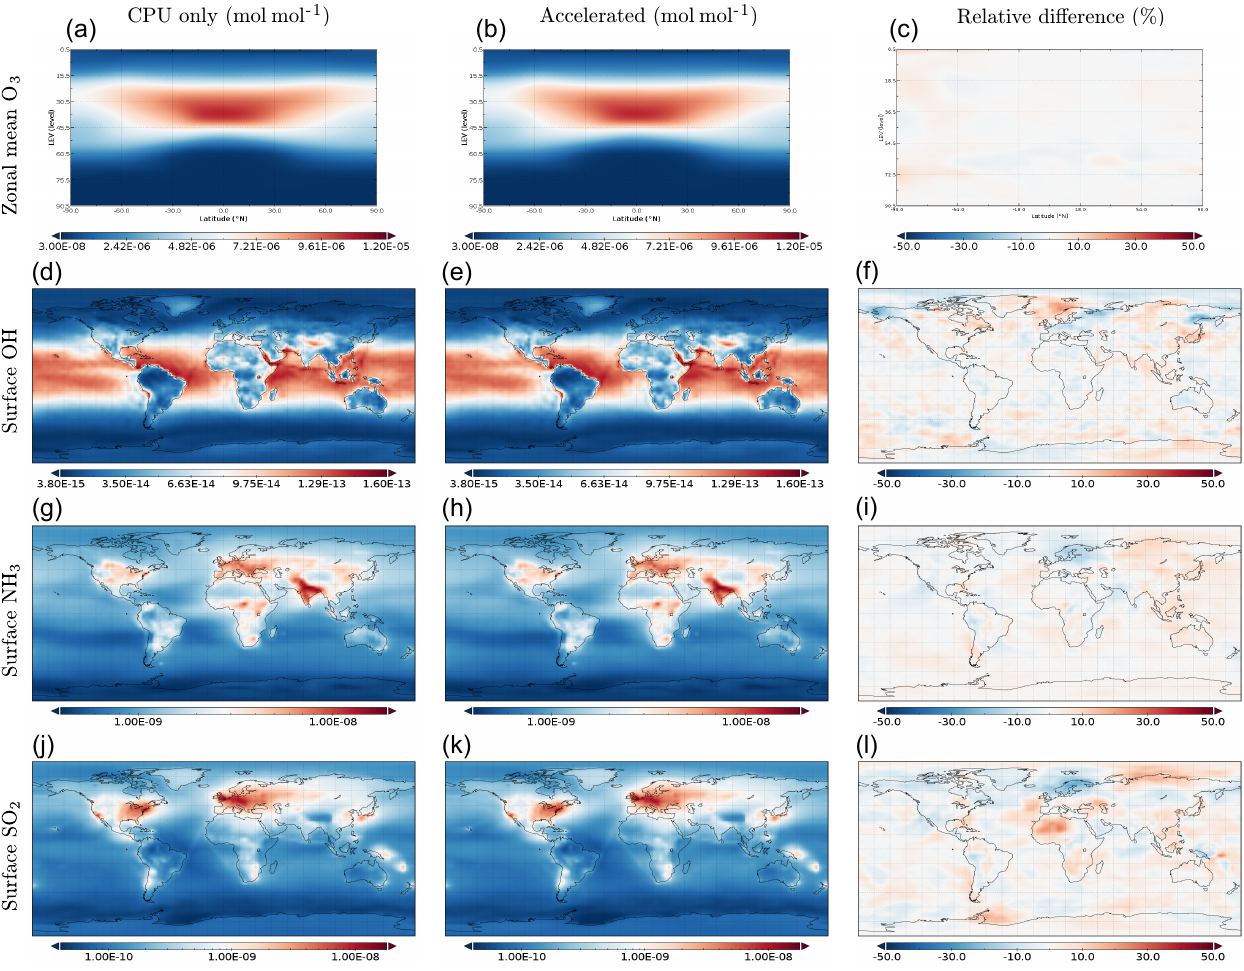
Figure 5. Output of CPU-only (a, d, j, g) , GPU-accelerated (b, e, h, k) 2-year simulations, and their relative difference (c, f, i, l) for different chemical species: O 3 zonal mean (a–c) and surface level OH , NH 3 , and SO 2 concentrations ( d–f , g–i , and j–l ,